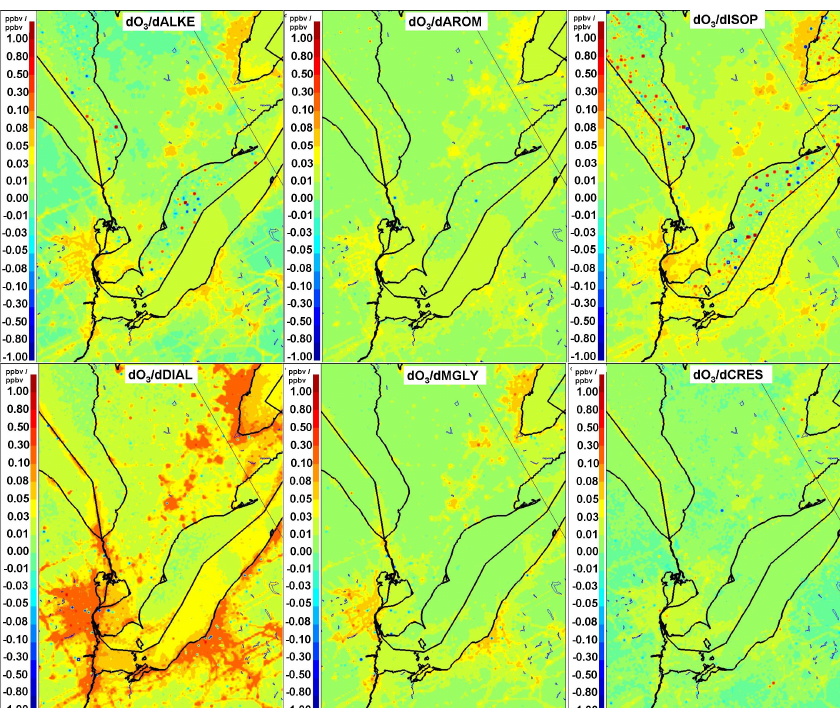
Fig. 22. Change in ozone after a two-minute timestep relative to change in (a) C 3 + Alkenes, (b) Xylenes and higher carbon number aromatics, (c) Isoprene, (d) Dialdehydes, (e) Methylglyoxal, and (f)